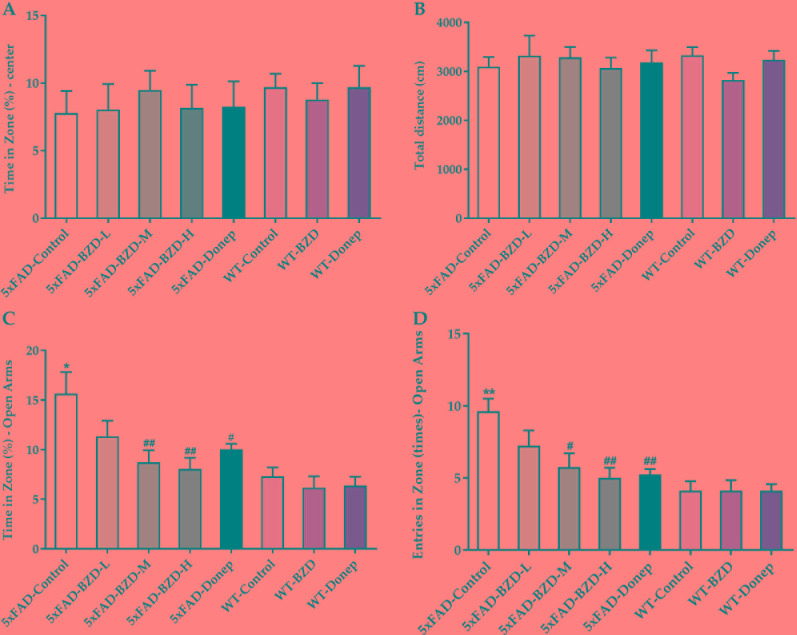
BZD alleviates anxiety-related behaviors in 5xFAD mice. (A, B) Mice (5xFAD-Control, 5xFAD-BZD-L, 5xFAD-BZD-M, 5xFAD-BZD-H, 5xFAD-Donep, WT-Control, WT-BZD and WT-Donep) were analyzed for duration in the center (A) and total travel distance (B) in the open field test. Data are expressed as the mean ± SD from 8 mice per group, not significant, One-Way ANOVA. (C, D) Mice (5xFAD-Control, 5xFAD-BZD-L, 5xFAD-BZD-M, 5xFAD-BZD-H, 5xFAD-Donep, WT-Control, WT-BZD and WT-Donep) were analyzed for time in zone – open arms (C) and entries in zone – open arms (D) in elevated plus maze. Data are expressed as the mean ± SD from 8 mice per group. *P < 0.05, ** P < 0.01 compared with WT-Control group; #P < 0.05, ##P < 0.01 compared with 5xFAD-Control group, One-Way ANOVA.